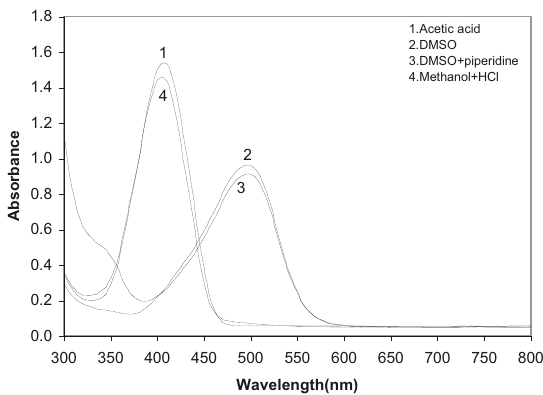
Figure 1. Absorption spectra of dye 3 in various solvents and acidic solution.